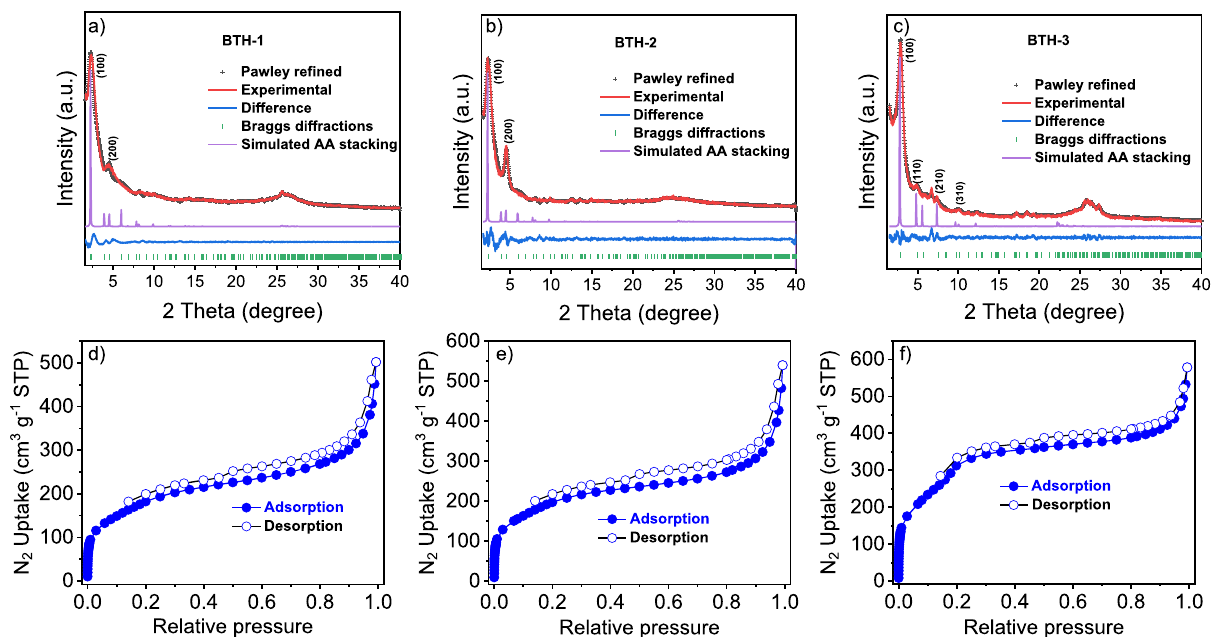
Fig. 3 Characterizations of the structures. a – c PXRD patterns of BTH-1, 2, 3 : experimental pattern (red), Pawley re fi ned pro fi le curve (black), Bragg diffractions (green), difference (blue), simulated patterns from AA eclipsed (purple); nitrogen adsorption and desorption isotherms of BTH-1 ( d ), BTH-2 ( e ), and BTH-3 ( f ).